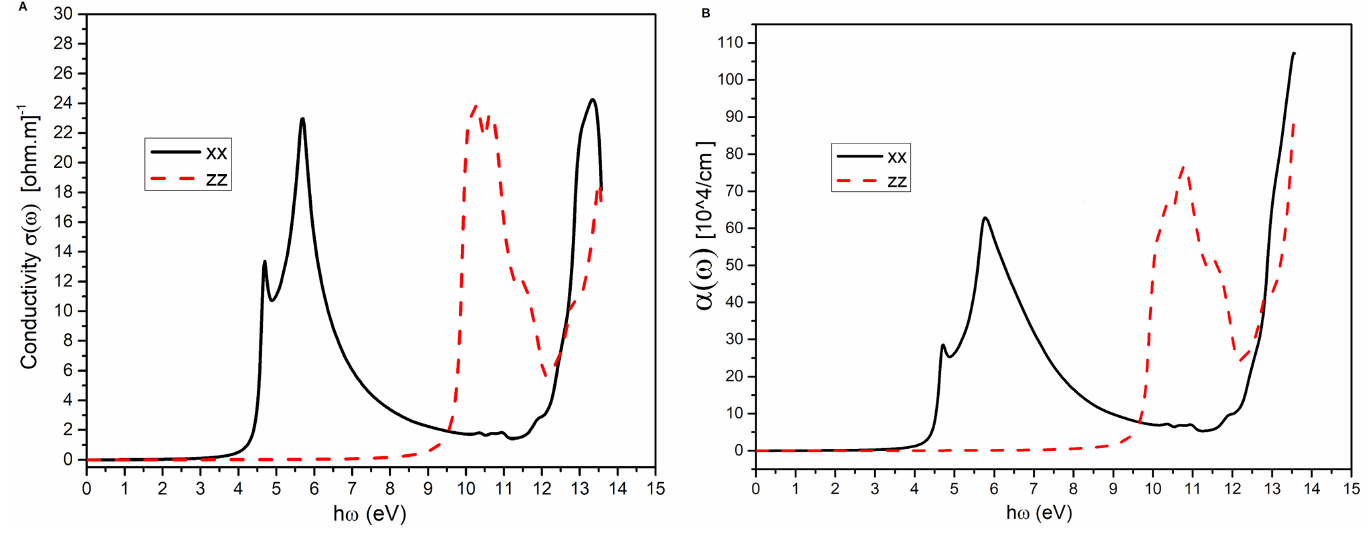
Figure 2 The optical conductivity. (A) The optical conductivities for ML h-BN in the xx in-plane and zz out of plane directions. (B) The absorption coef fi cients for ML h-BN in the xx in-plane and zz out of plane